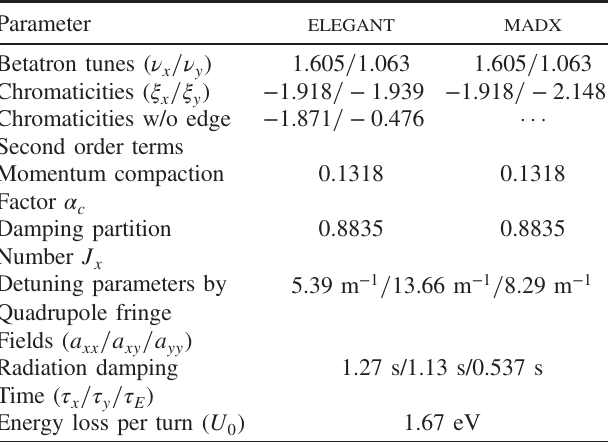
TABLE I. Lattice parameters.